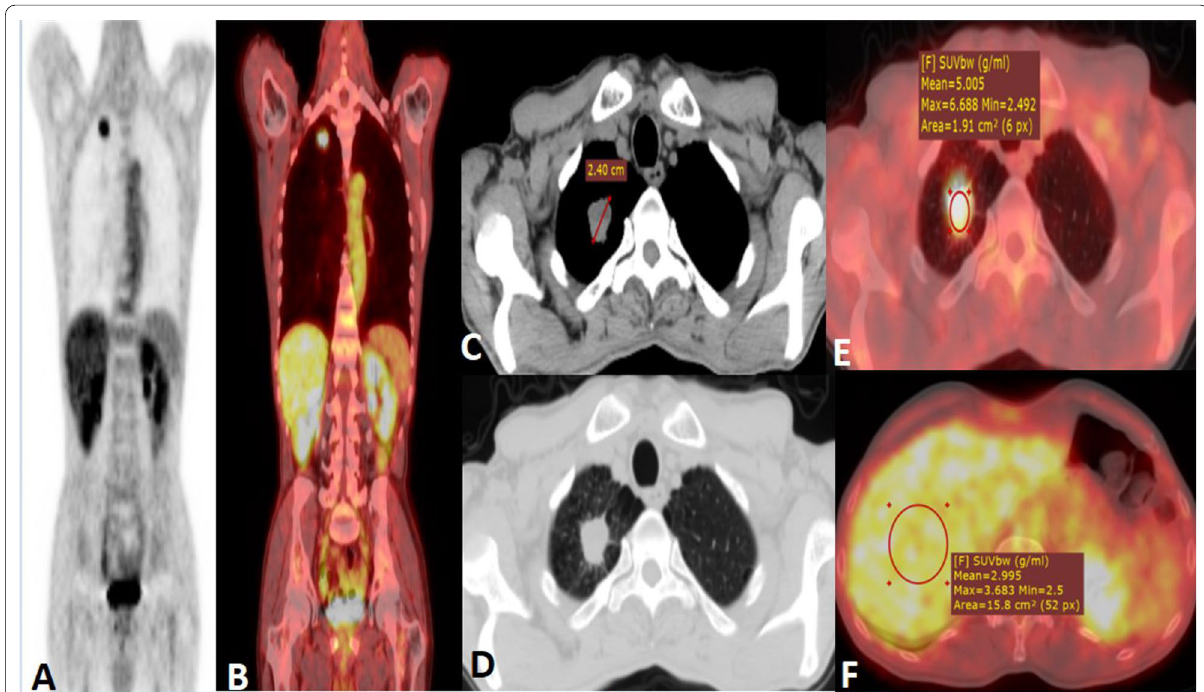
Fig. 4 A 56-year-old male patient proved histopathologically to have adenocarcinoma (AC) involving the right upper lobe. A (coronal PET), B (coronal PET/CT), C (axial CT in a mediastinal window), D (axial CT in a lung window), E and F images (axial PET/CT images). The mass lesion size measured in the C image was 2.4 cm with SUVmax of the tumor was 6.69 as shown in E . TLR was calculated to be 6.69/3.72